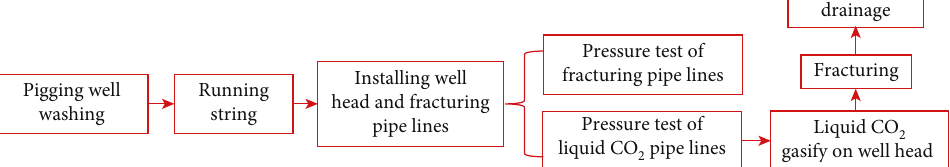
Figure 7: Operating technique process.